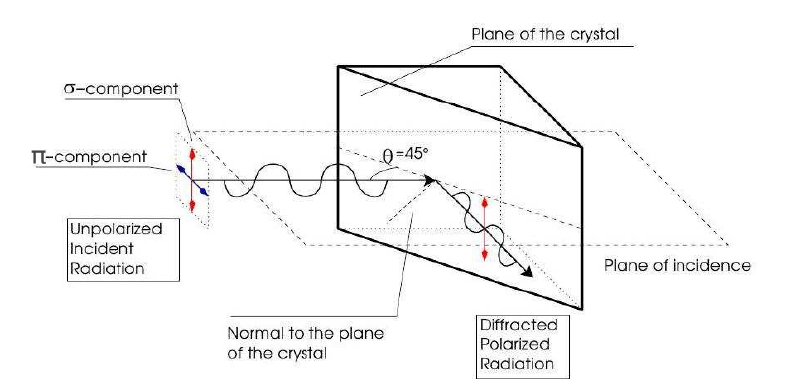
Figure 2. Schematic representation of Bragg diffraction at 45 ◦ on a crystal. The radiation component, which is polarized perpendicularly with respect to the plane of incidence, is efficiently diffracted, while the radiation component that have a parallel polarization with respect to this plane is absorbed by the